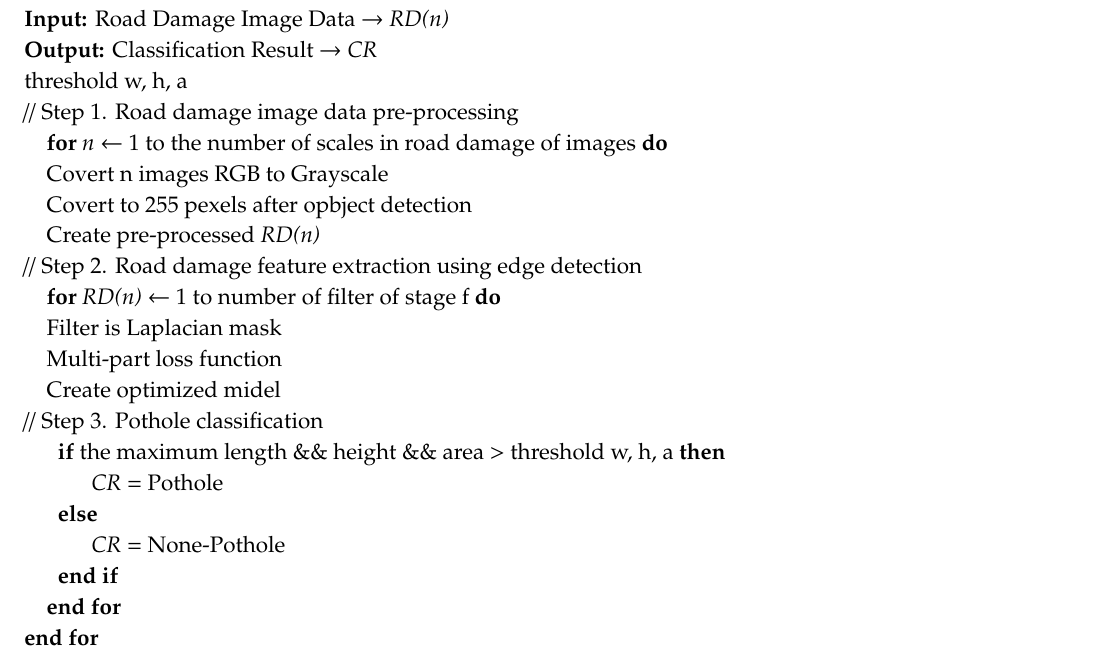
Algorithm 1. Algorithms for pothole classification based on YOLO (you only look